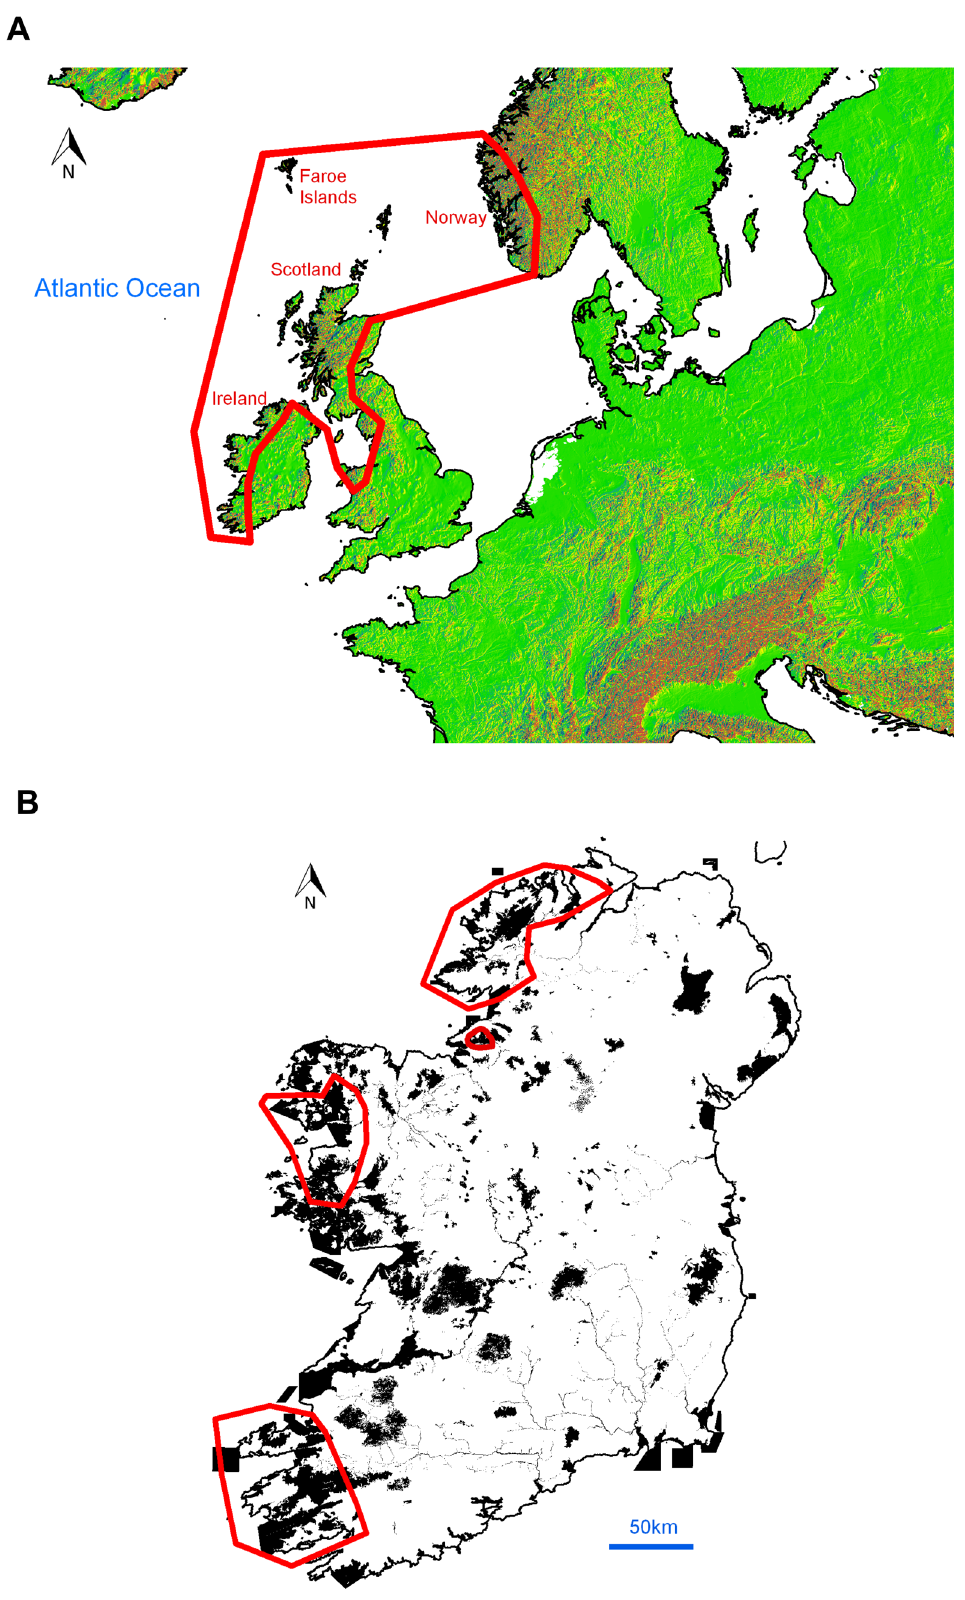
Figure 1. Maps showing the distribution of oceanic montane vegetation in Europe and Ireland. (A) Distribution range (red line) of temperate oceanic montane vegetation in Europe. (B) Main areas (red lines) where conditions are currently optimal for the occurrence of oceanic montane vegetation in Ireland, i.e. areas of altitude over 500 m, that are within the area defined as hyperoceanic by [94]; shaded areas are sites